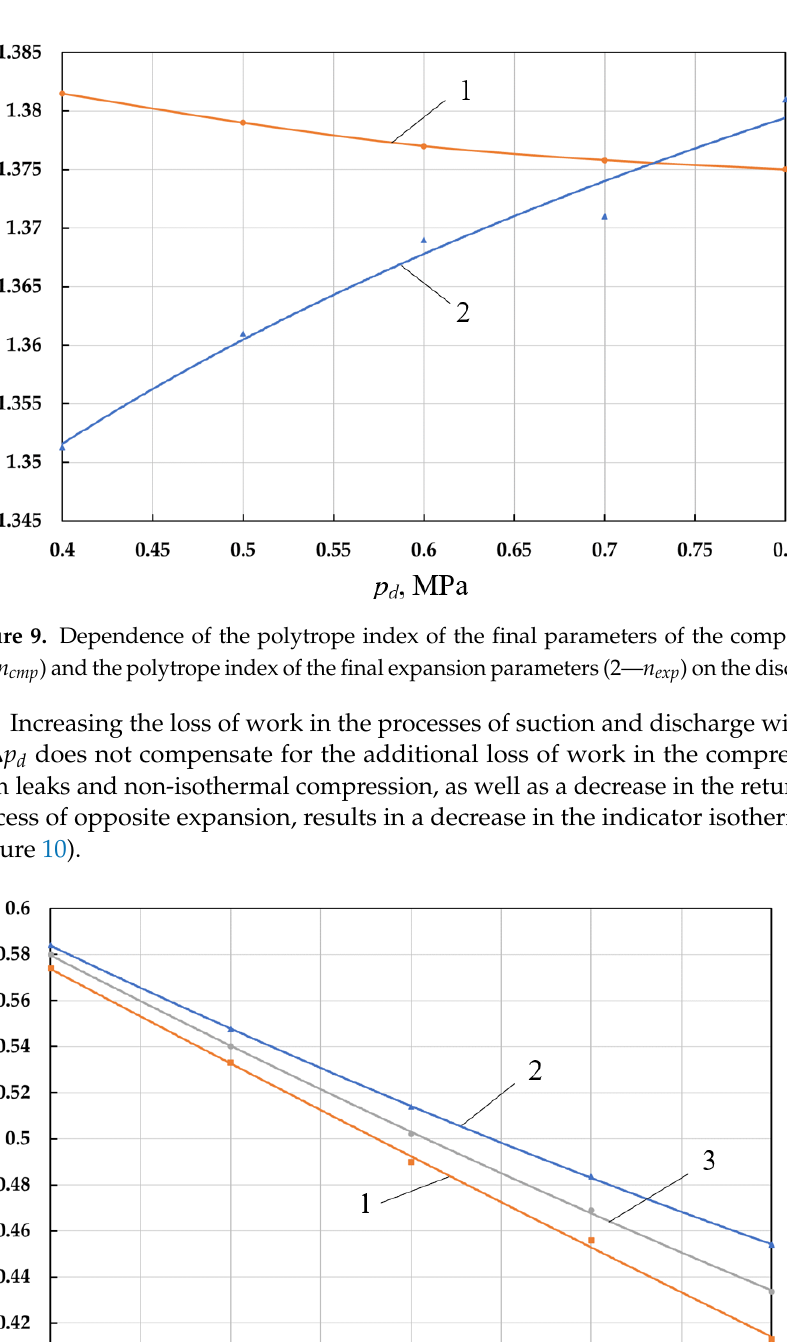
Figure 11. Dependence of average pressures per cycle in cavities 21 (1 — p p2.av ) and 22 (2 — p p1.av ) on the discharge pressure. Reducing the pressure difference in cavities 21 and 22 results in a reduction in coolant flow. The value Q w1 decreases from 285.3 L/min to 243.6 L/min, i.e., about (15 – 17)% (Figure 12).